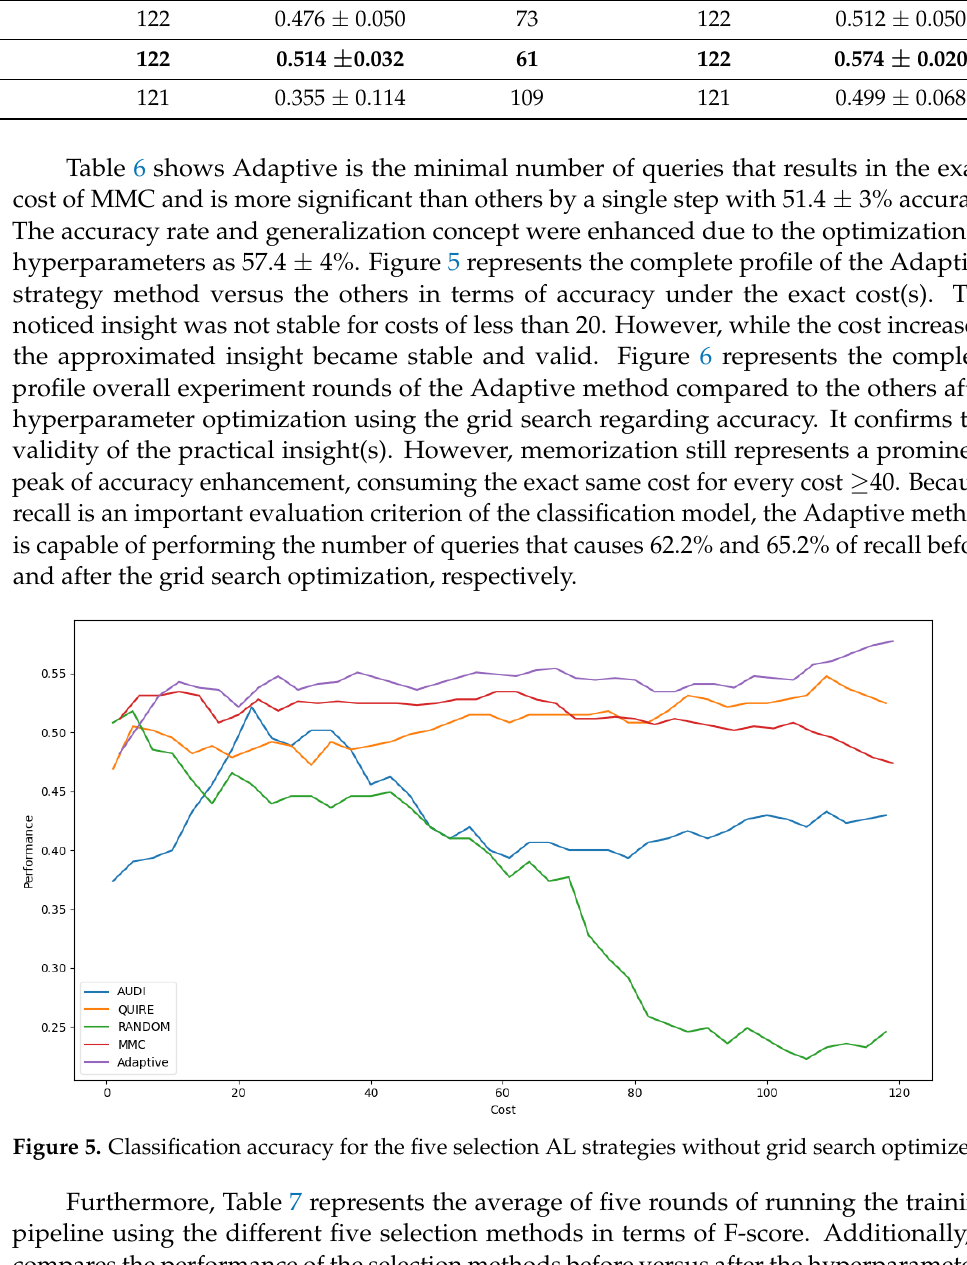
Figure 6. Classification accuracy for the five selection AL strategies with grid search optimizer. Furthermore, Table 7 represents the average of five rounds of running the training pipeline using the different five selection methods in terms of F-score. Additionally, it compares the performance of the selection methods before versus after the hyperparame- ters’ optimization procedure by the grid search. We noted that the Adaptive selection method can achieve a higher F-score rate for the learned model with a generalization con- cept than one with a memorization concept for any classical ML model(s) before the grid search optimization. The Adaptive method reached 62.3 ± 4%, advancing ahead others by at least 1.26% of the generalization concept. However, as a response to the optimization process, the AUDI selection method achieved a better F-score. It reached 62.2 ± 3.6% of the F- score versus the Adaptive’s score, which decreased by 1.68%. Figure 7 represents the complete profile of the Adaptive strategy method versus oth- ers in terms of F-score under the exact same cost(s). Unfortunately, the cost metric does not indicate a threshold of stability insight about the F-score of the Adaptive method. How ever, it performed better when the cost value was ≥ 60. During the cost increase, the approximated insight became stable and valid. Figure 8 represents the complete profile of the overall experiment rounds of the QUIRE method, comparing it with others after